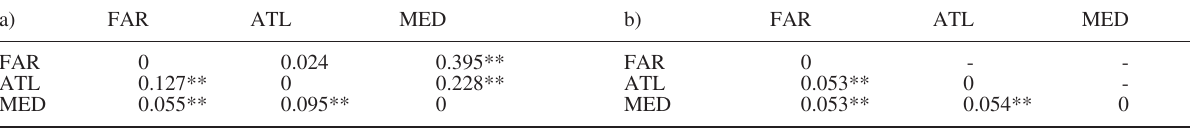
Table 4. – F values of the analysis of the molecular variance (AMOVA) for three Senegalese sole populations. ST